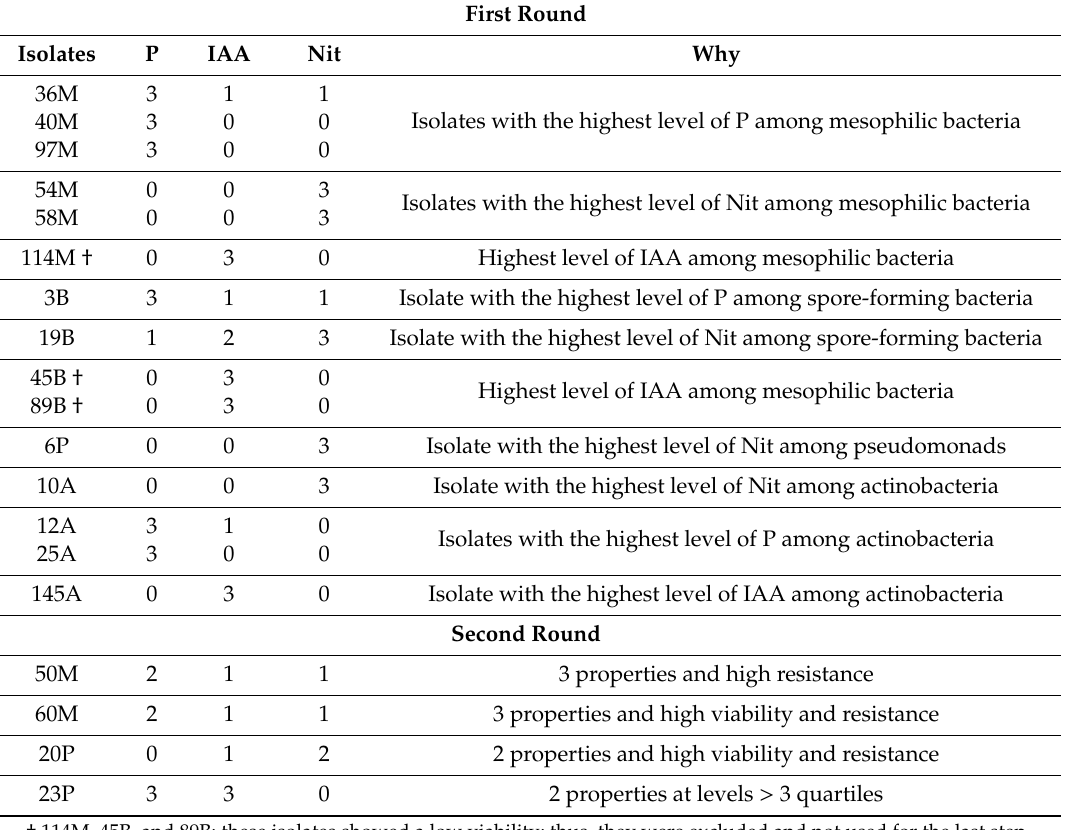
Table 5. Selected isolates. Codes and criteria for the choice. P, P-mineralization; IAA, indole acetic acid production; nit,